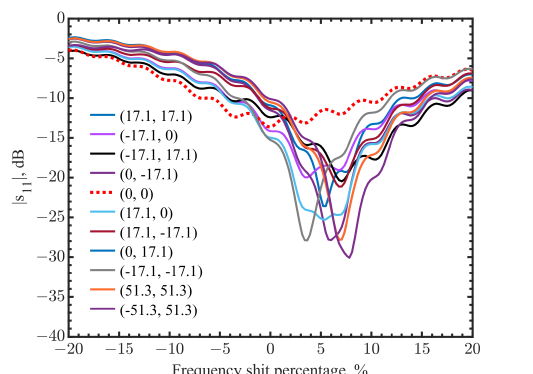
Figure 14. Comparison of normalized frequency shifts in measurements at the center (dashed line), the neighbor pixels, and two pixels at the corners (solid lines). The pixel location is indicated as (x, y) on the map, and the tumor is at the center as (0,